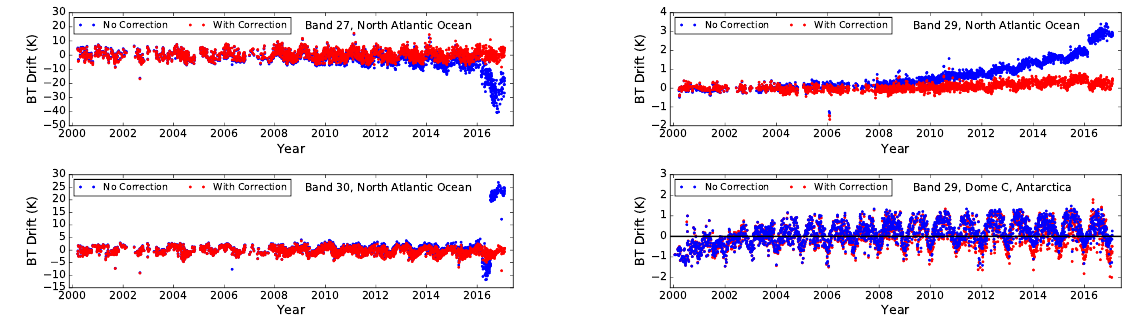
Figure 11. Examples of the brightness temperature drift relative to band 31 for selected bands and scenes. For each set of data, the drift is normalized to the averaged brightness temperature offset in 2003 for the uncorrected data. For the Dome C data for band 29, a black line is shown as a reference for the center of the oscillations in the brightness temperature